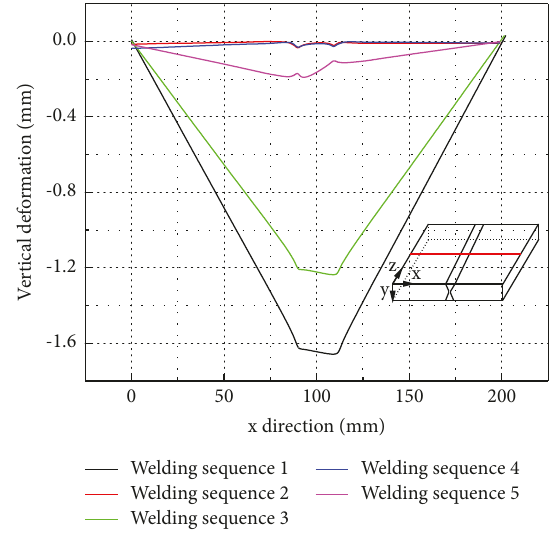
Figure 21: Comparison of the vertical